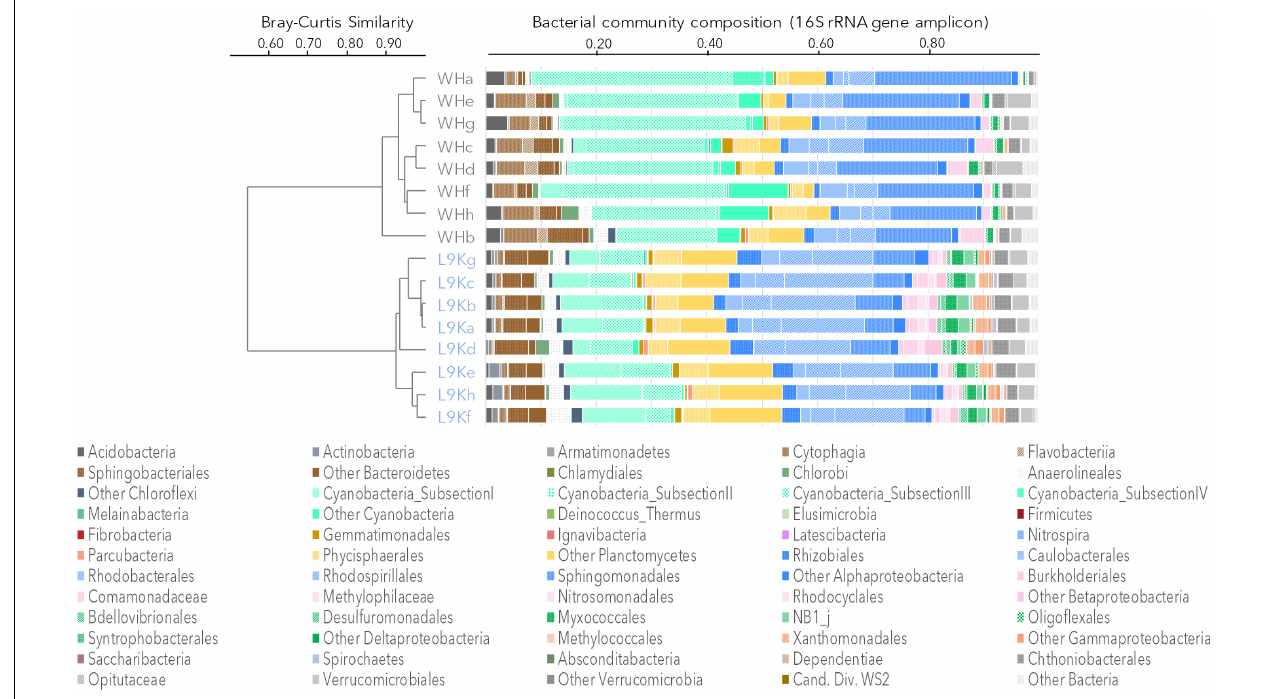
FIGURE 2 | Bacterial community composition based on 16S rRNA gene amplicons. Samples were clustered using the Bray-Curtis similarity measure: Ward Hunt Lake mats (WH), Lake 9K mats (L9K). Major lineages are color coded: Bacteroidetes (browns), Cyanobacteria (light greens), Planctomycetes (yellow), Alphaproteobacteria (blue), Betaproteobacteria (pink), Deltaproteobacteria (dark green), Gammaproteobacteria (orange), and Verrucomicrobia